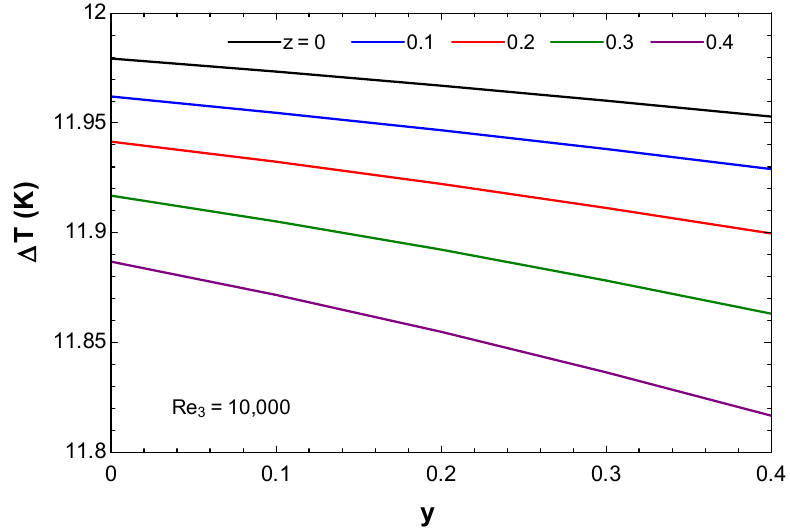
Energies 2021 , 14 , x FOR PEER REVIEW Figure 3. Effect of airflow ratios on temperature increase. Figure 3. Effect of airflow ratios on temperature increase.